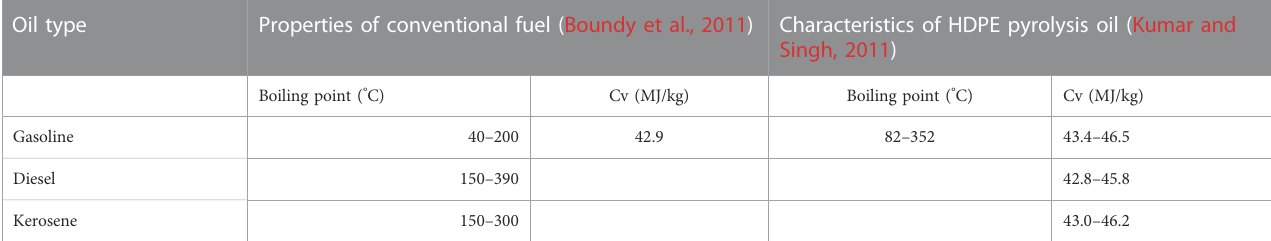
TABLE 6 Properties comparability of conventional fuel and pyrolytic HDPE oil. Oil